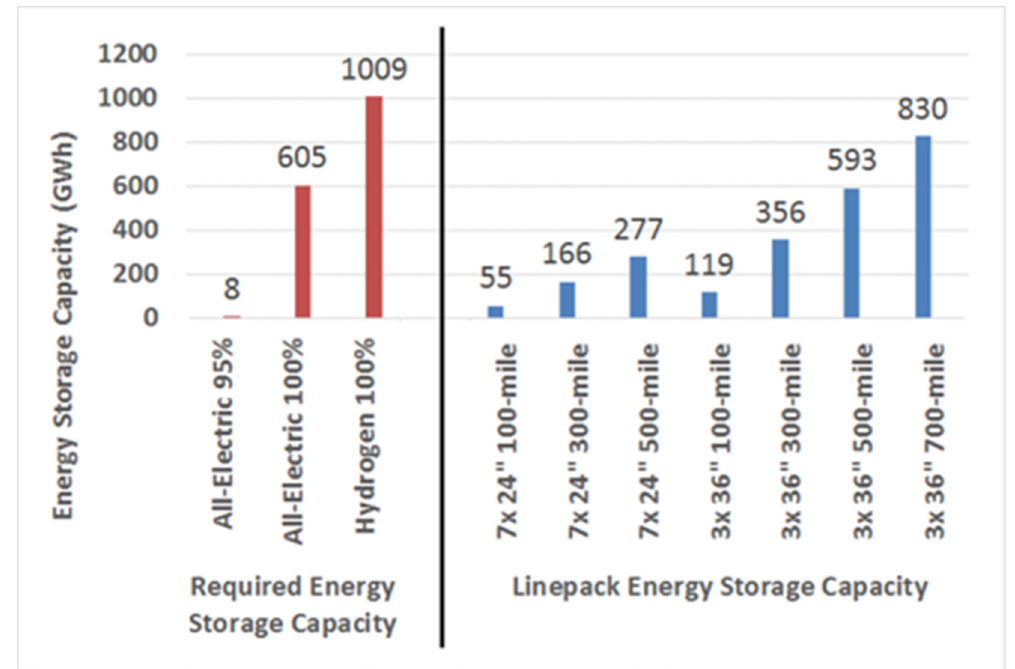
Figure 8. Comparison of shifting energy storage capacity for each respective pathway (red) and the amount of pipeline linepack (blue) to meet the 1200 MW peak demand profile.